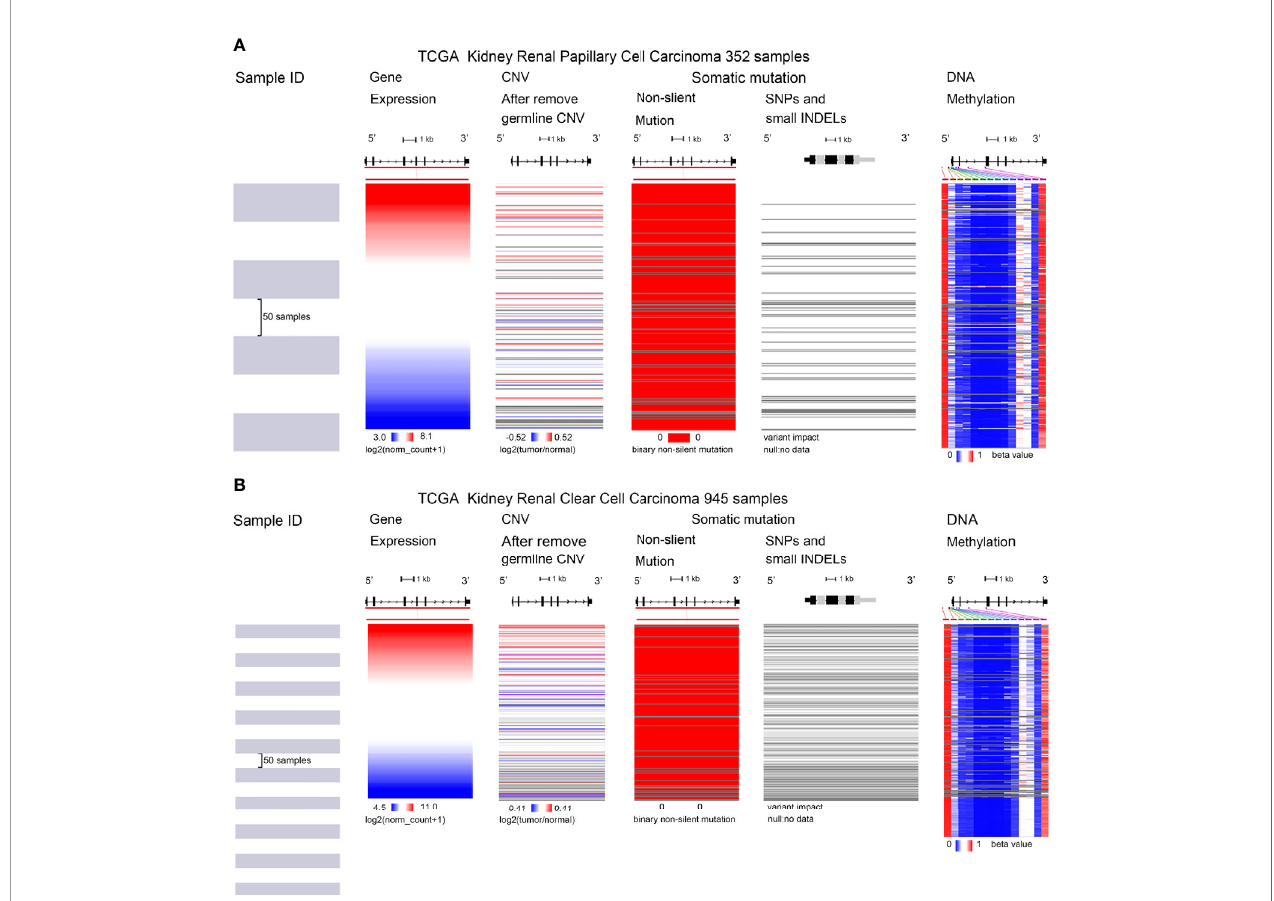
FIGURE 6 | Mutation, CNV, and methylation analysis of CTHRC1 in KIRP and KIRC. (A, B) Heatmap showing the correlations between CTHRC1 mRNA and somatic mutations, CNV, and methylation in KIRP (A) and KIRC (B) via UCSC